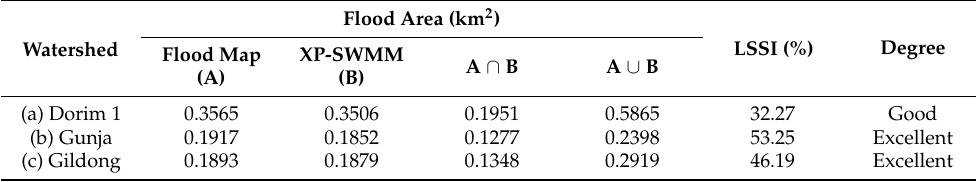
Table 10. Result of LSSI